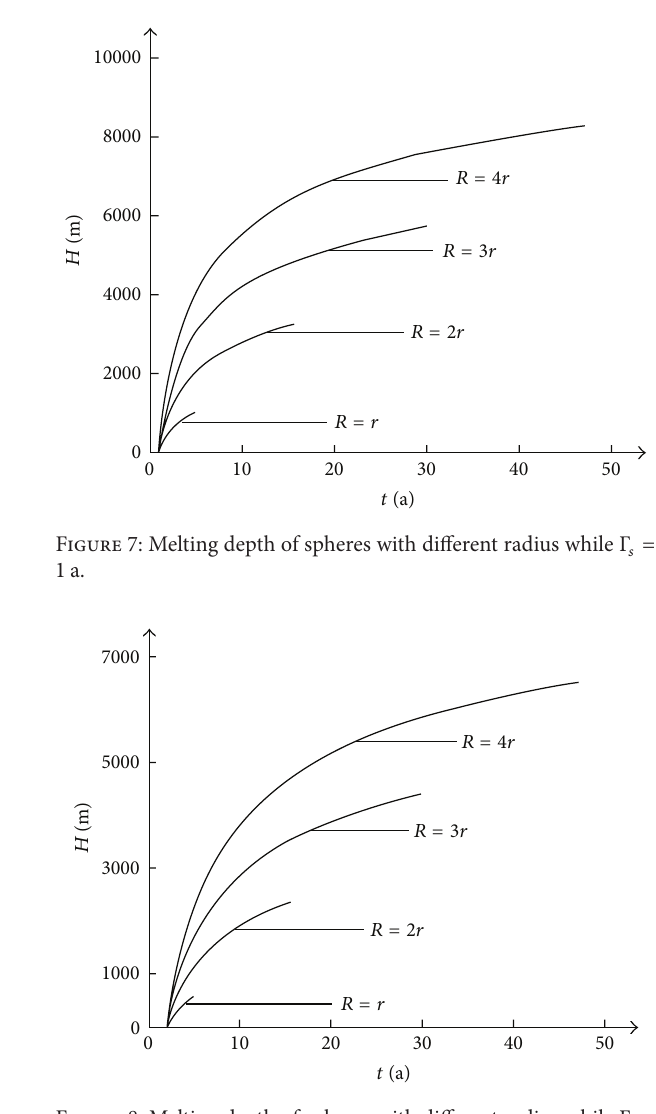
Figure 6: Melting depth of spheres with different radius while Γ 𝑠 = 0.5 a.